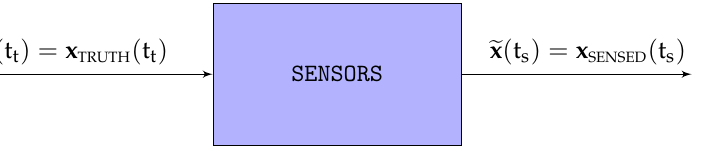
Figure 1. Sensors flow